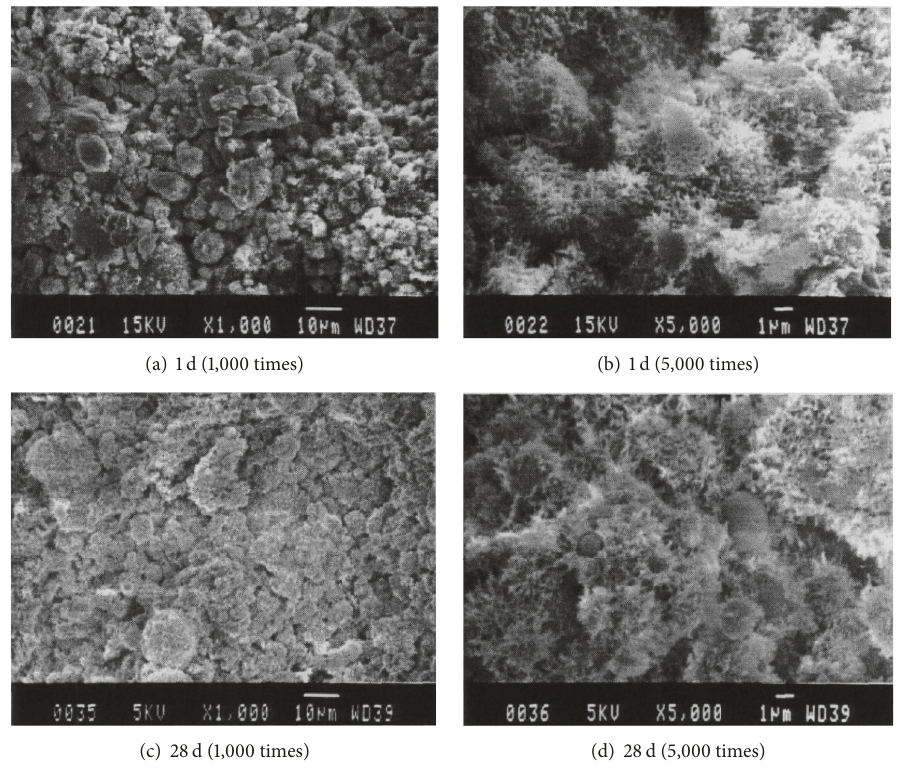
Figure 8: SEM scan grams on materials at different curing ages.